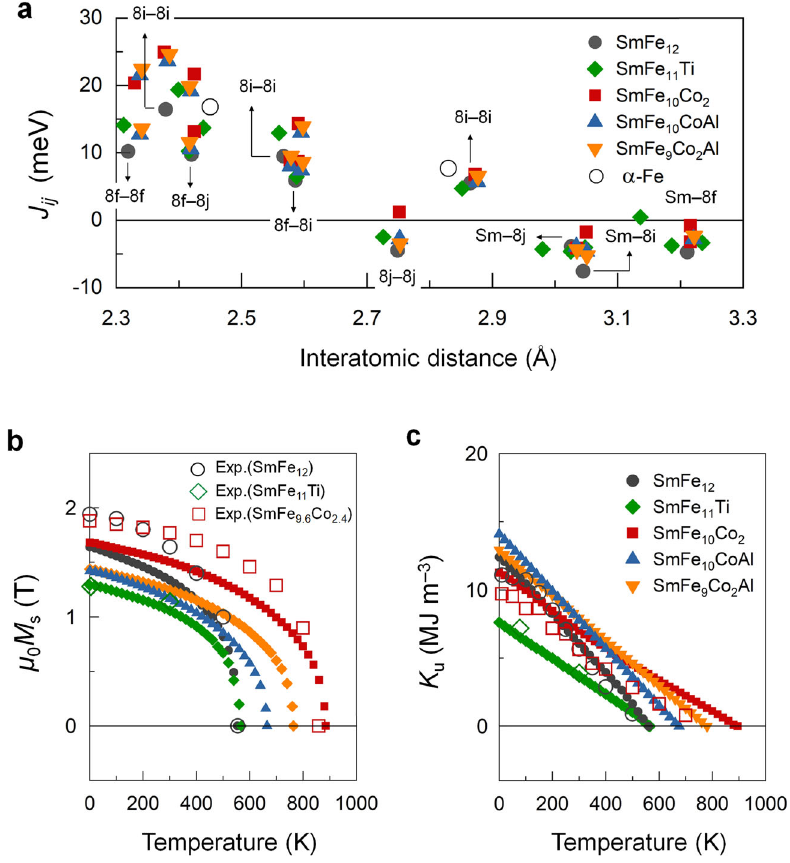
Fig. 7 Temperature-dependent intrinsic magnetic properties. a Exchange interaction parameters J ij as a function of the interatomic distance, b saturation magnetization μ 0 M s versus temperature, and c uniaxial magnetocrystalline anisotropy K u versus temperature of SmFe 12 , SmFe 11 Ti, SmFe 10 Co 2 , SmFe 10 CoAl, and SmFe 9 Co 2 Al. In a the nearest- and next-nearest-neighbor exchange interactions of the α -Fe structure are shown in the open circles. Open symbols in b and c denote the experimental data for SmFe 12 , SmFe 11 Ti, and SmFe 9.6 Co 2.4 , taken from refs. 15 – 17,22,23 .